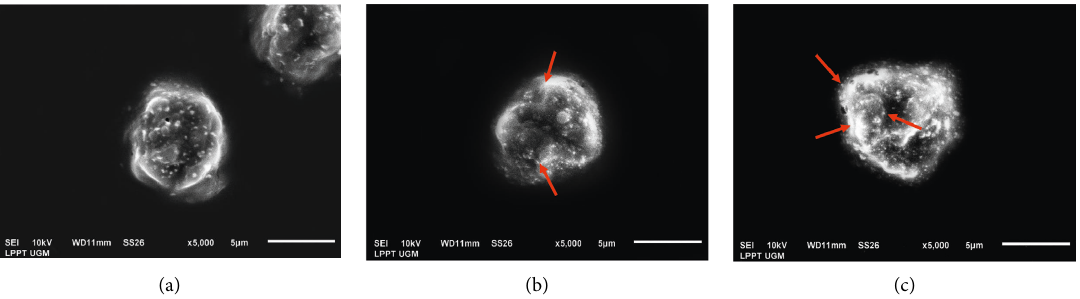
Figure 3: Representative scanning electron microscopy of Raji cells of control ((a) untreated) showing normal Raji cell characteristics and cells treated with meloxicam ((b):100 μ M; (c):200 μ M) showing the telltale morphology of an apoptotic cell with a ruffled and blebbed